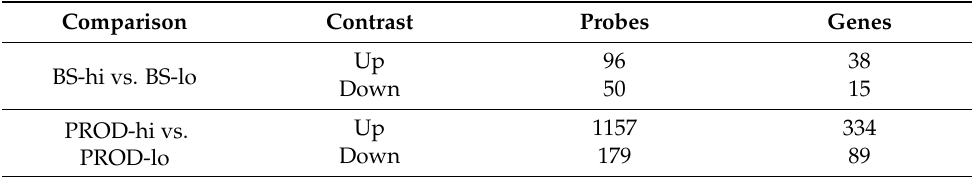
Table 4. Differentially expressed genes per contrast.